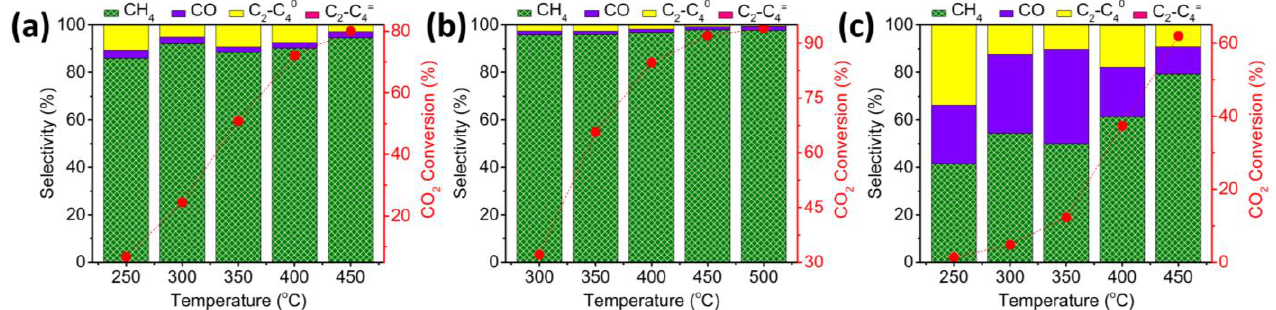
Figure 5. CO 2 conversion and selectivity for samples 5 – 7 at different temperatures. ( a ): sample 5; ( b ): sample 6 and ( c ): sample 7. Reaction condition: H 2 /CO 2 ratio of 7, total flow 4 mL/min, 10 bar, 40 mg catalyst.). The error of the measurements is lower than 10%.